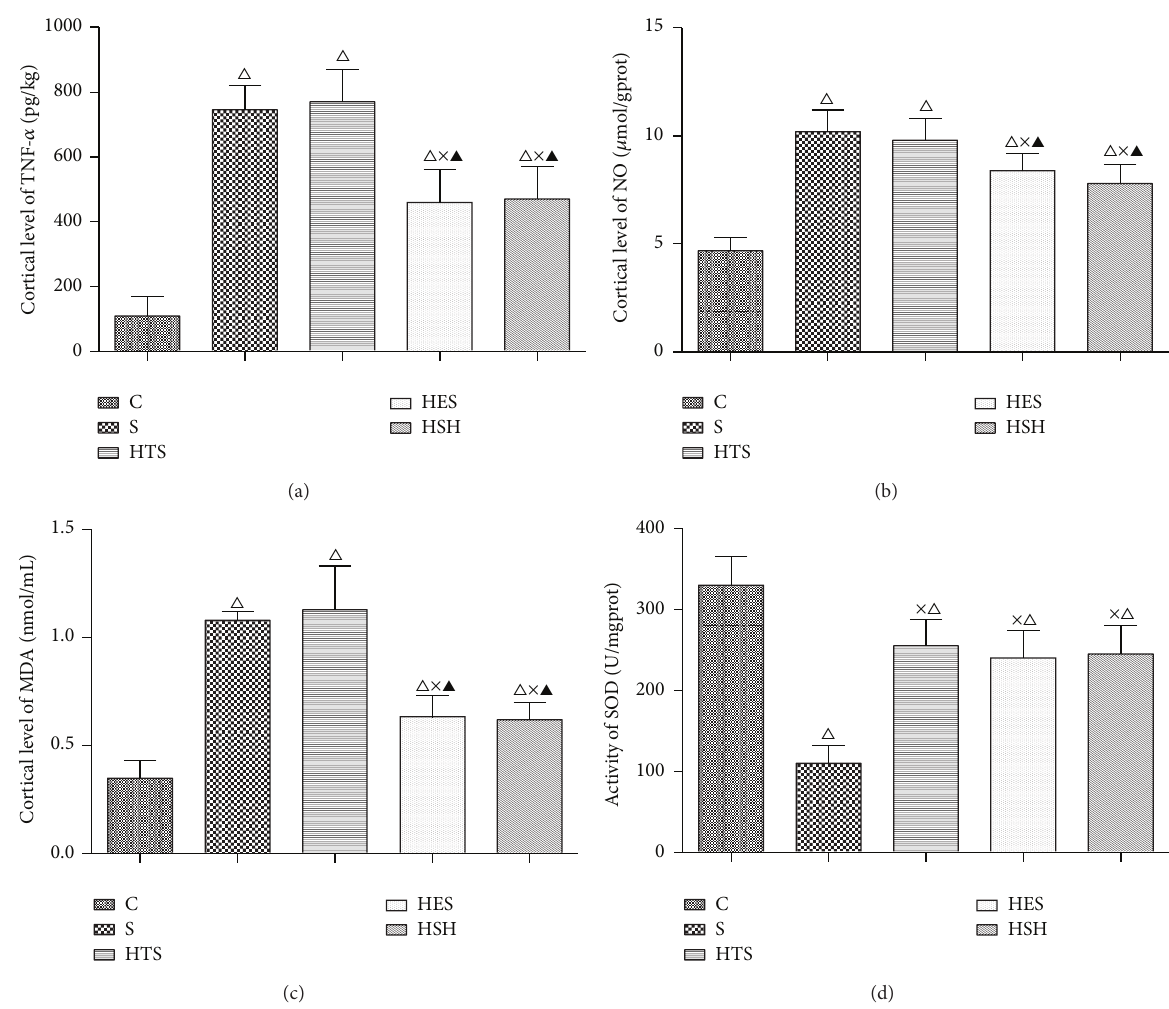
Figure 4: Variations in biochemical indexes in the different treatment groups. △ 𝑃 ≤ 0.0 , compared to group C; × 𝑃 ≤ 0.05 compared to group S; 󳵳 𝑃 ≤ 0.05 compared to the HTS